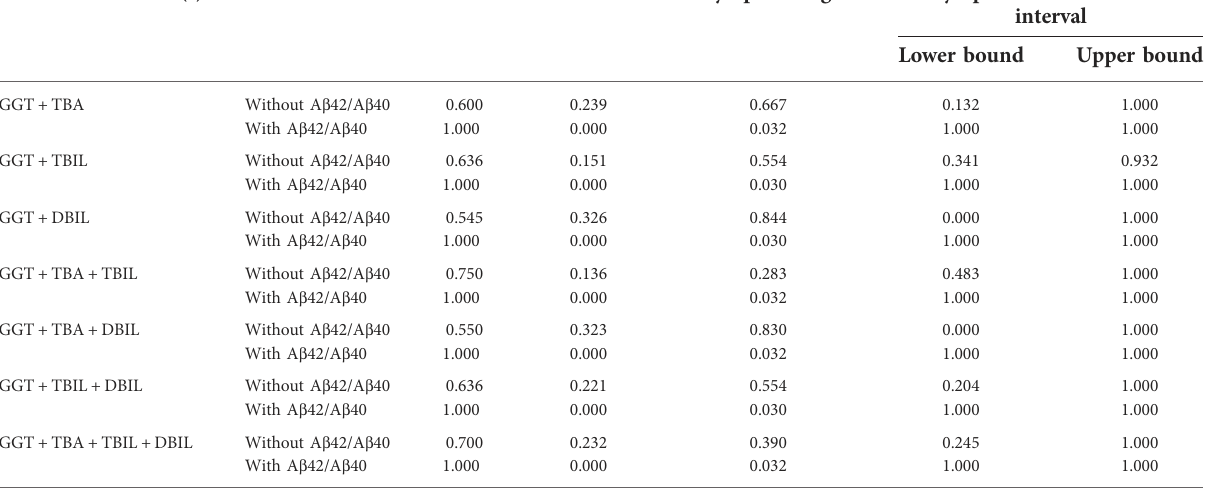
TABLE 6 Area under the curve of γ -glutamyl transpeptidase and other hepatic function parameters with/without A β 42/A β 40 for the diagnosis of biliary